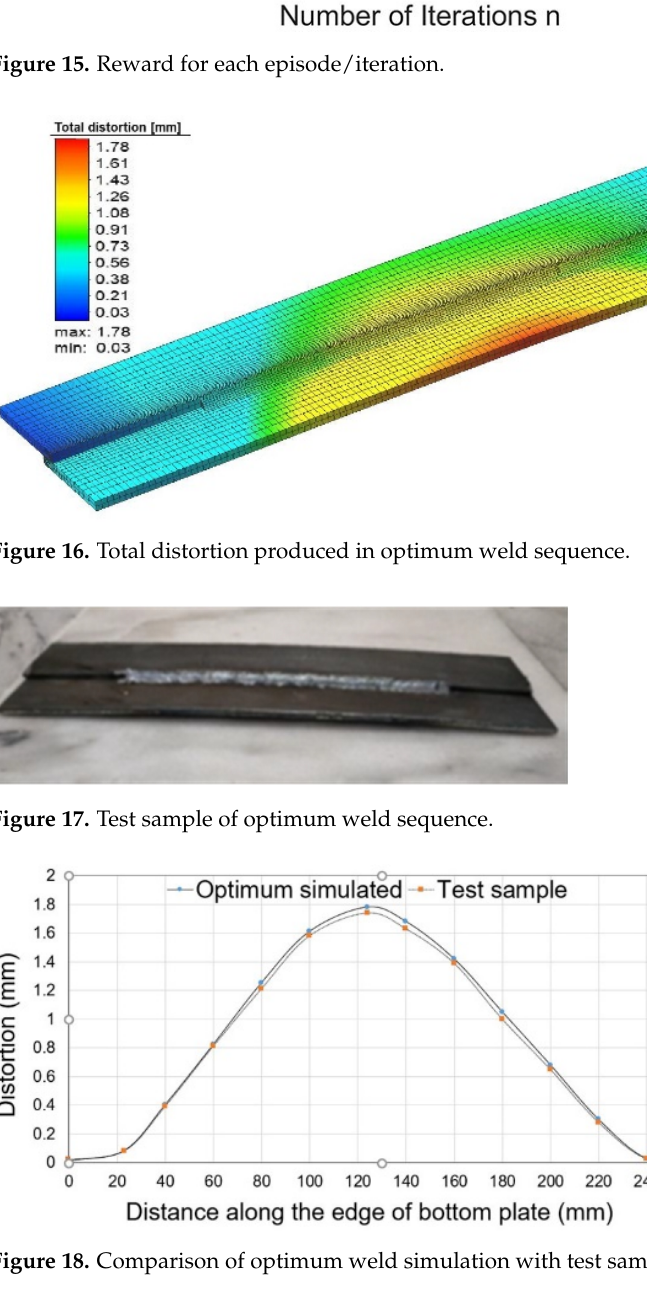
Figure 15. Reward for each episode/iteration.